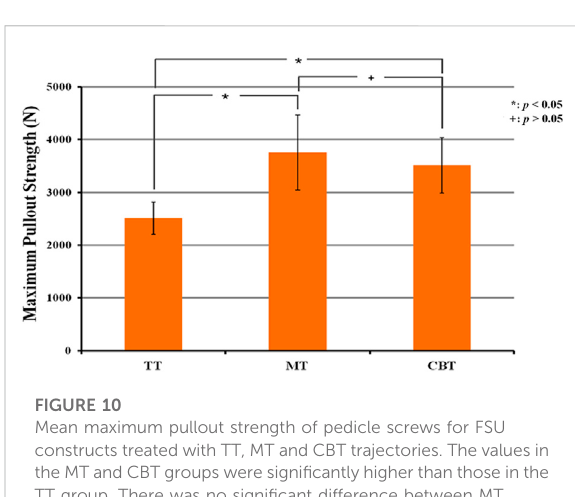
Mean maximum pullout strength of pedicle screws for FSU constructs treated with TT, MT and CBT trajectories. The values in the MT and CBT groups were signi fi cantly higher than those in the TT group. There was no signi fi cant difference between MT and CBT